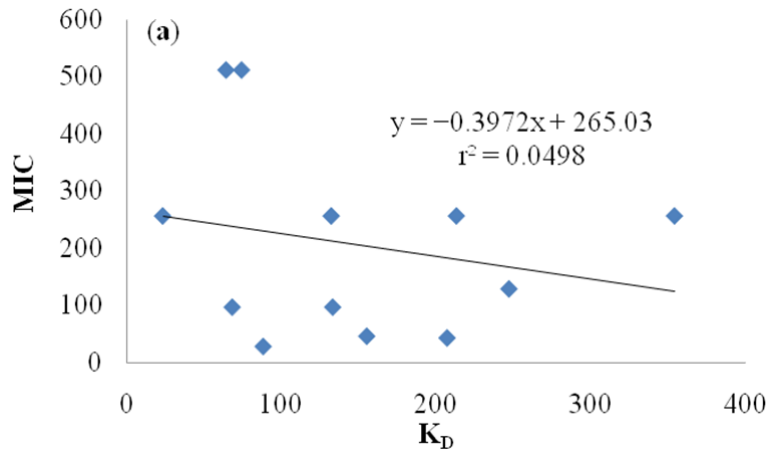
Figure 1. MIC–K plots for ( a ) E . coli and ( b ) E . faecalis D